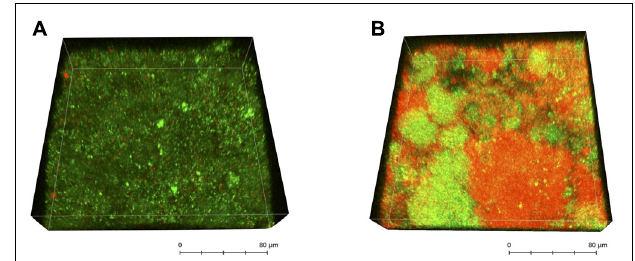
FIGURE 3 | 3D-reconstruction of a LIVE/DEAD-stained confocal image stack of a supragingival oral biofilm after treatment with CHX. The biofilm was formed in situ on a bovine enamel slab for 72 h (methodology as described in Al-Ahmad et al., 2015) and was either left untreated (A) or was treated with 0.2% CHX for 5 min (B) . Bacteria with intact (green; considered “live”) or compromised bacterial membranes (red; considered “dead”) are depicted indicating “pockets of viable cells” within the biofilm.